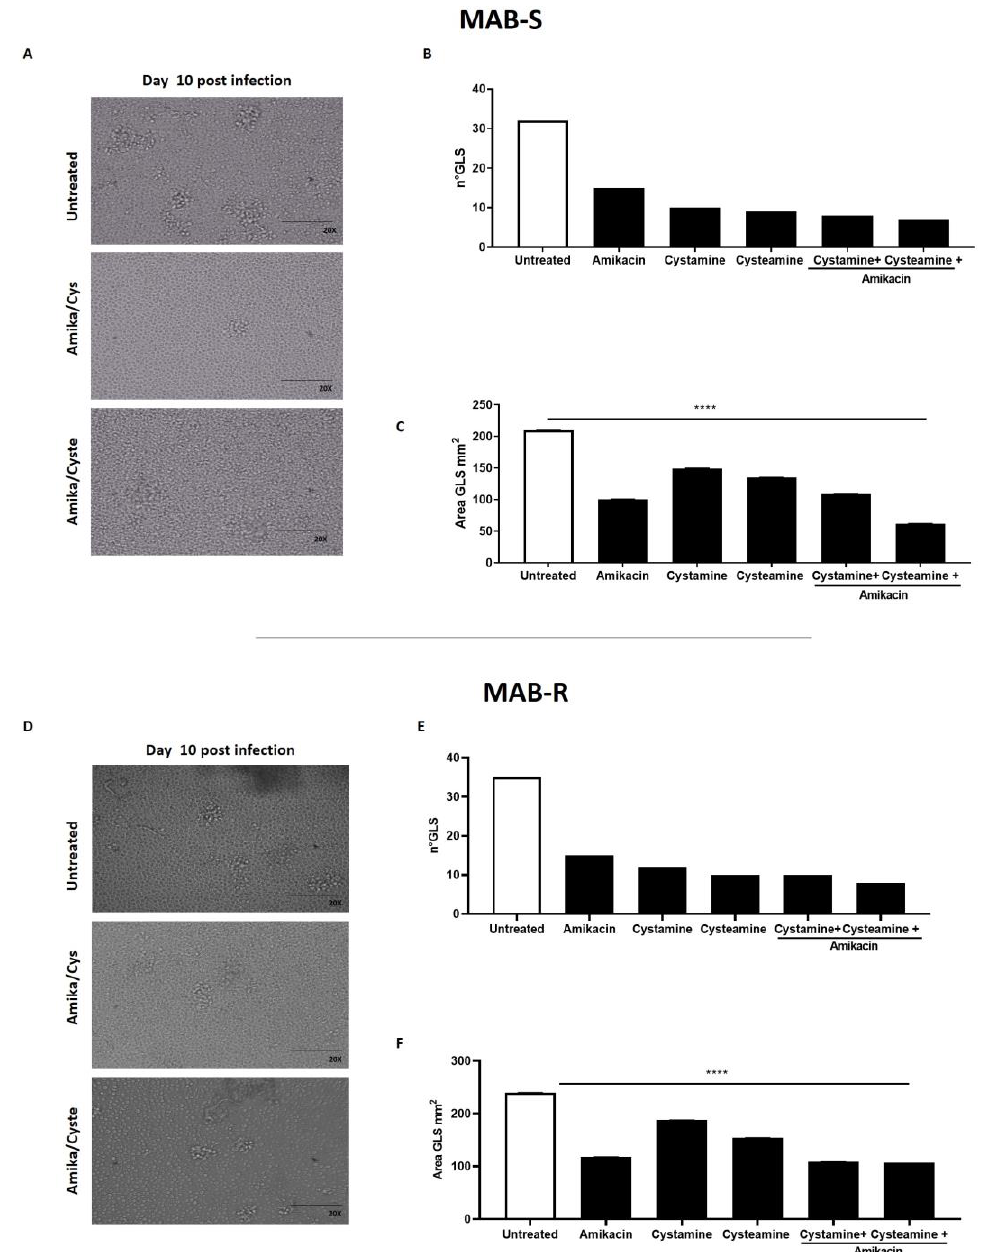
Figure 3. Evaluation of the anti-TG2 treatment in the GLS model of M. abscessus infection. PBMCs obtained from healthy donors were infected with the MAB-S and -R variants, respectively, and left to mature into GLSs for up to 10–12 days. GLSs were treated with different drugs starting at 3 days post-infection: cystamine (400 µM), cysteamine (800 µM), and amikacin (4 µg/mL). Representative light microscopy images of GLSs 10 days post-infection (magnification 20X) infected with MAB-S ( A ) and MAB-R ( D ). At this time point, assessing 12 fields/sample, we measured the number of the GLSs infected with MAB-S ( B ) and MAB-R ( E ) and the average surface of GLS in 12 fields (MAB-S ( C ) and MAB-R ( F ). The means ± standard deviations of scores representative of three experiments each are given the images; **** p < 0.0001 by one-way ANOVA with Dunnett’s multiple-comparisons test compared with untreated condition.